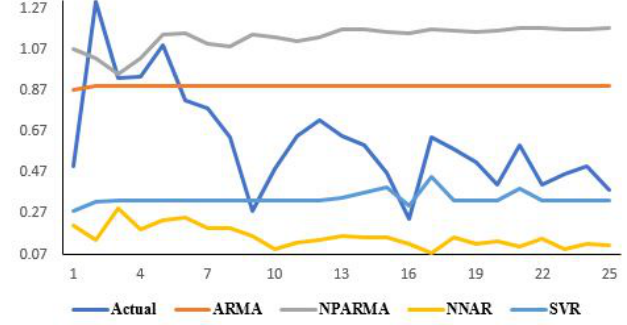
Figure 13. Forecasting performance of the